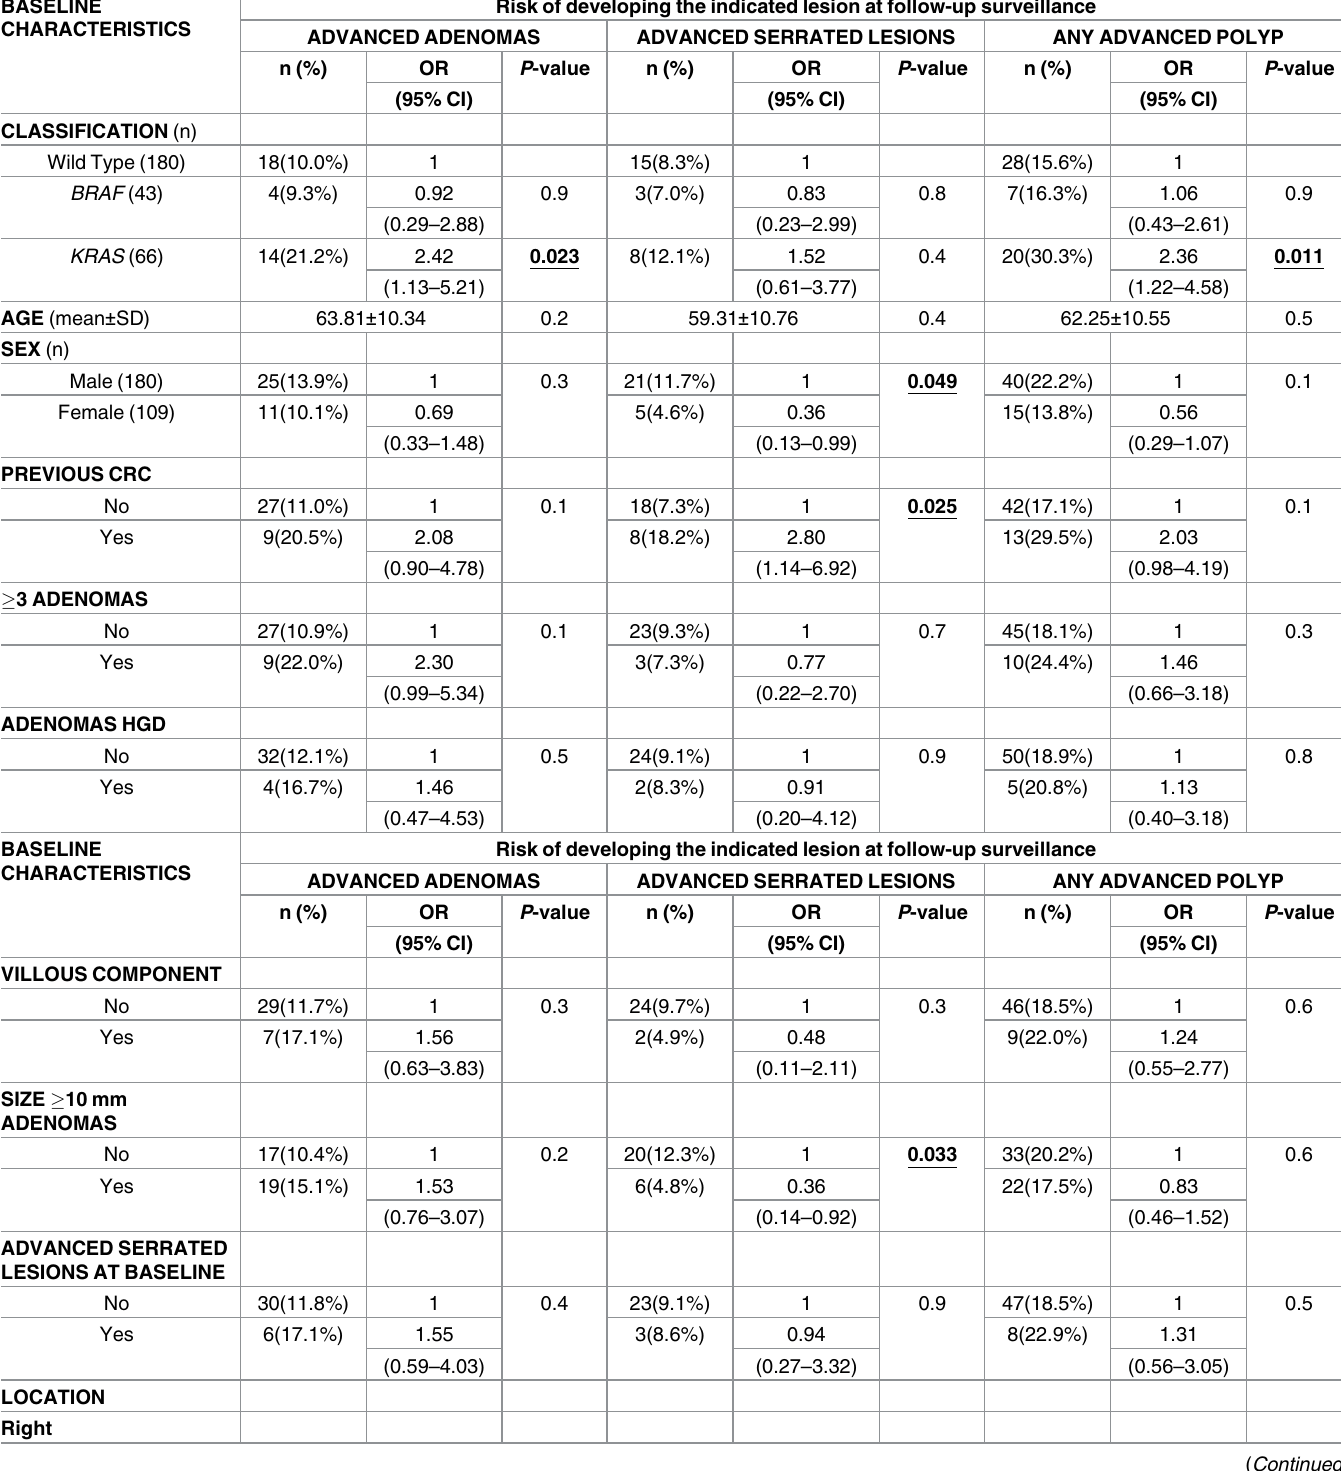
Table 3. Univariate logistic regression analysis of risk of developing advanced lesions at surveillance, according to molecular and clinical charac- teristics of patients at the baseline colonoscopy. BASELINE